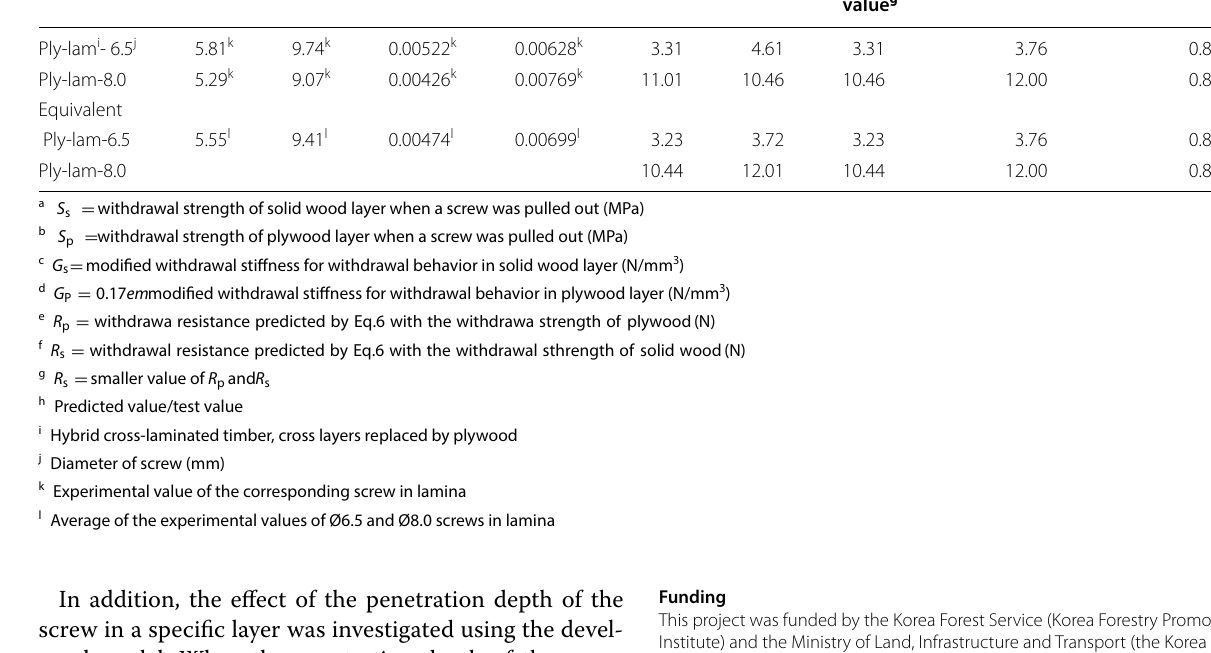
Table 4 Results of measured and predicted withdrawal resistance for Ply-lam